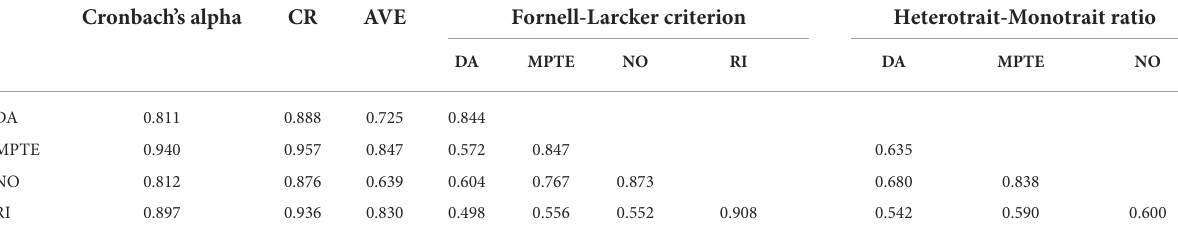
TABLE 4 Reliability, construct validity, and correlation.